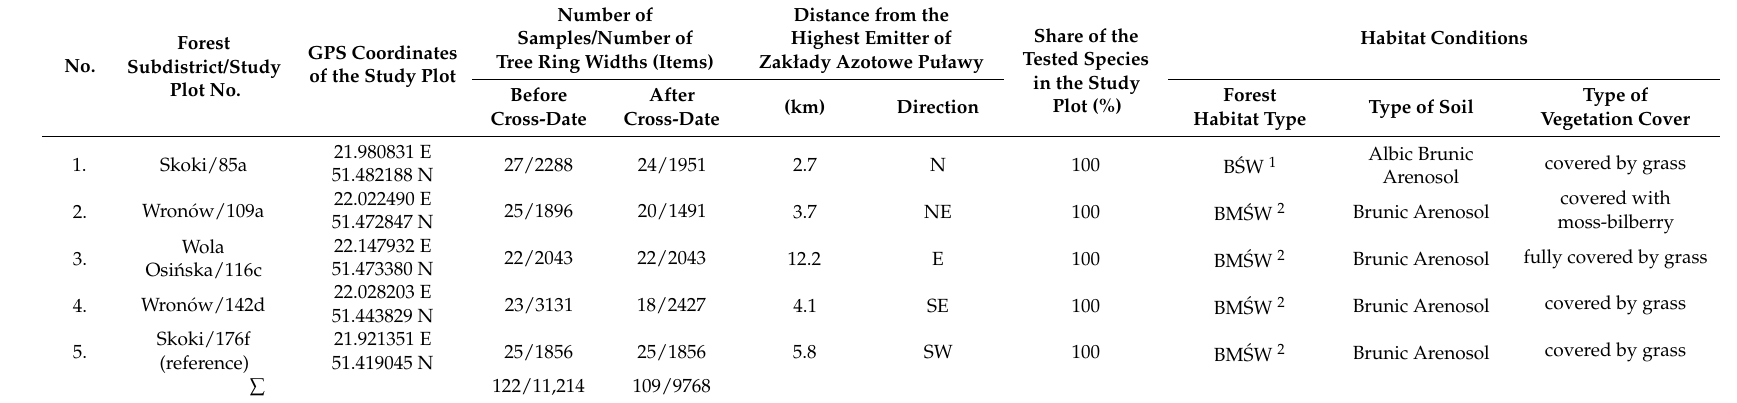
Table 1. Taxation description of forest in Puławy Forest District, in which research material in the form of increment core samples was collected and the number of samples